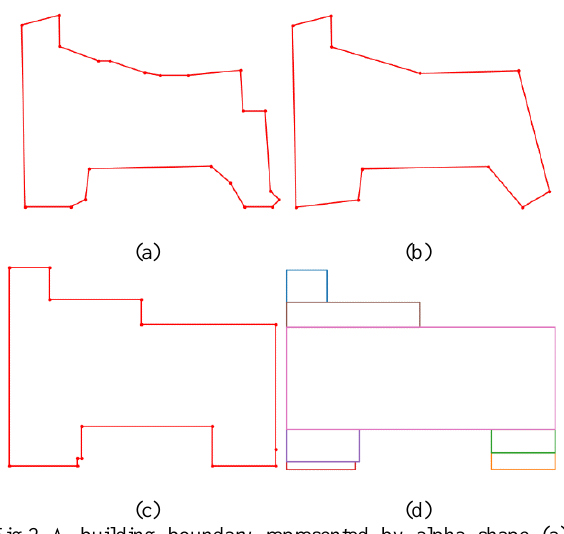
Fig.2 A building boundary represented by alpha shape (a), Douglas-Pecker (b), regularization (c), GEON decomposition